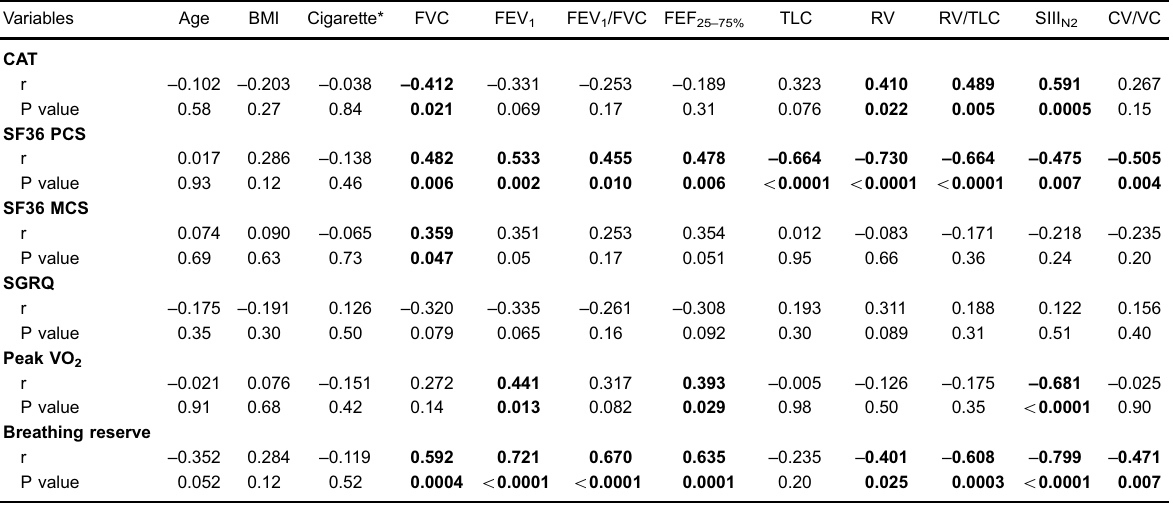
Table 2. Pearson ’ s correlation coef fi cients for demographic, clinical, resting pulmonary function and cardiopulmonary exercise test variables. Variables